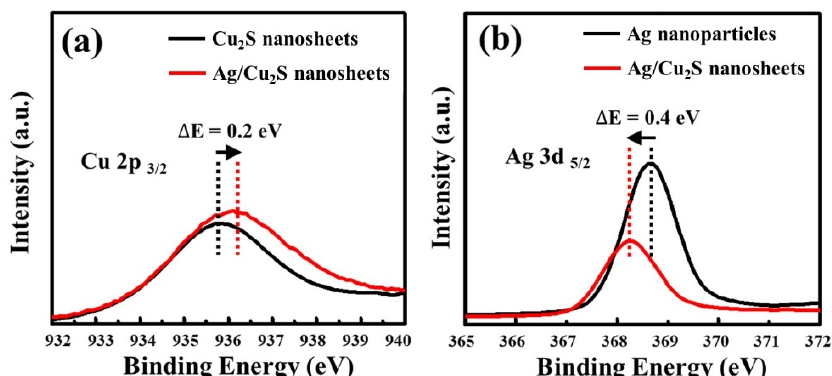
Figure 4. High resolution XPS spectra of Cu 2 S, Ag NPs, and Ag/Cu 2 S nanosheets: ( a ) Cu 2p 2/3 and ( b ) Ag 3d 5/2 .